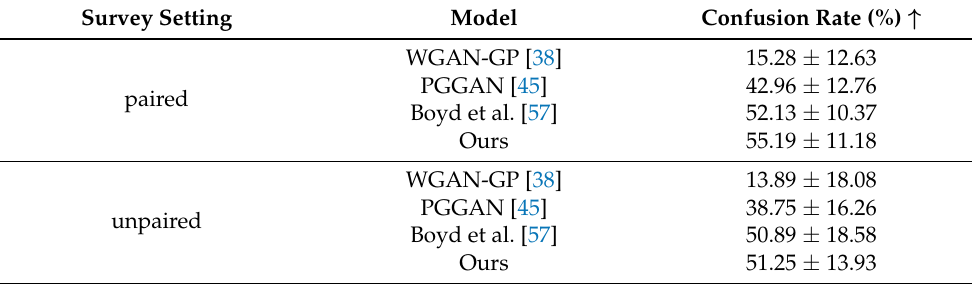
Table 1. The qualitative evaluation results of our study. The confusion-rate measurement result by model in the paired setting (top). The confusion-rate measurement result by model in the unpaired setting (bottom).